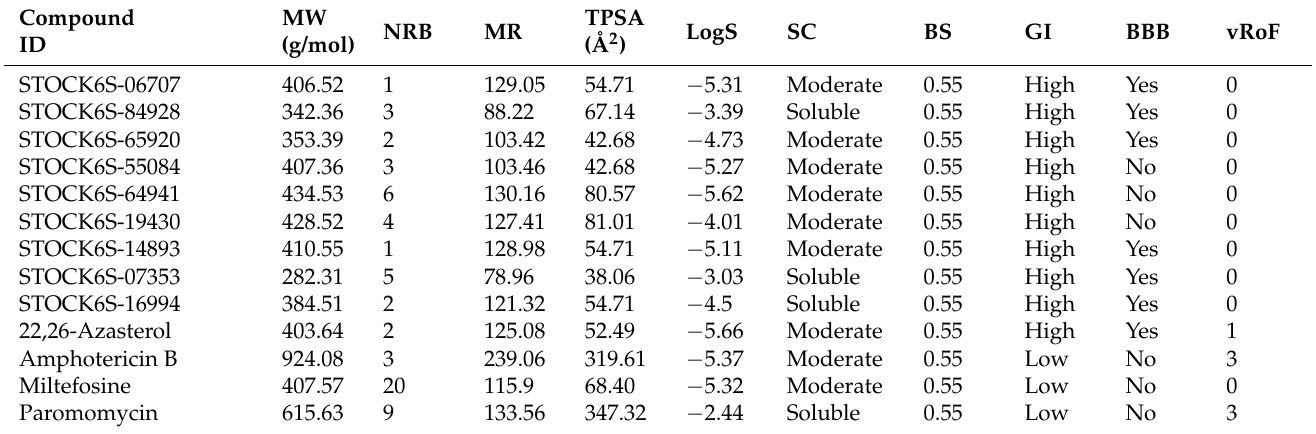
Table 3. Predicted physicochemical and pharmacological properties of the selected hit